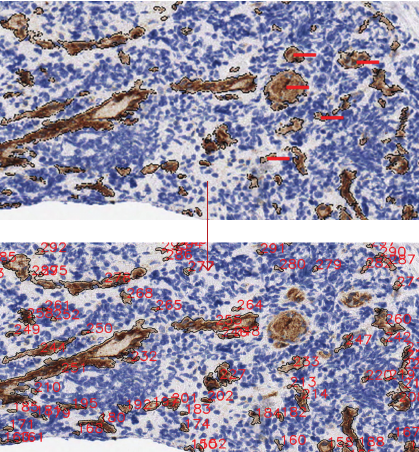
Figure 6: Working session with AngioPath in manual mode. Selection of nondesired vessels to be eliminated in the TMA image.